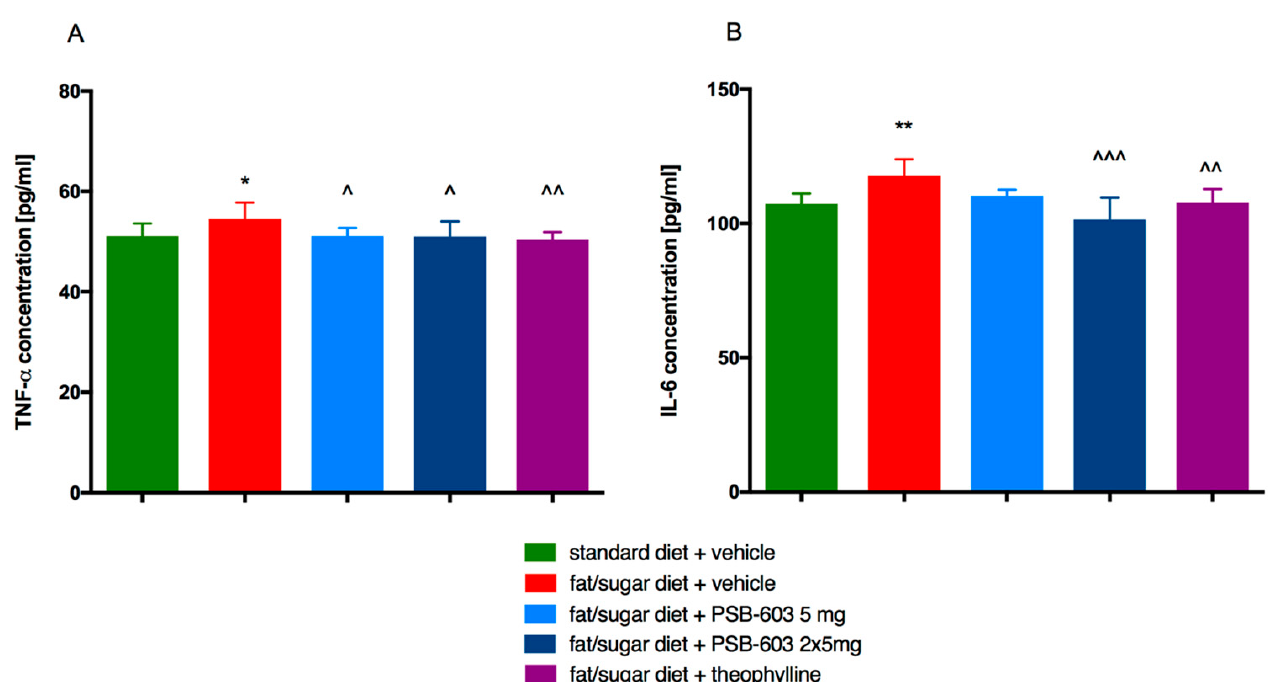
Figure 9. Effect of PSB-603 administration on ( A ) TNF- α and ( B ) IL-6 levels in plasma. Results are expressed as means ± SD, n = 8–10. Comparisons were made by one-way ANOVA Tukey post hoc; * significant compared to control mice fed a standard diet; ^ significant compared to control mice fed a fat/sugar diet; *, ^ p < 0.05, **, ^^ p < 0.01, ^^^ p < 0.001.